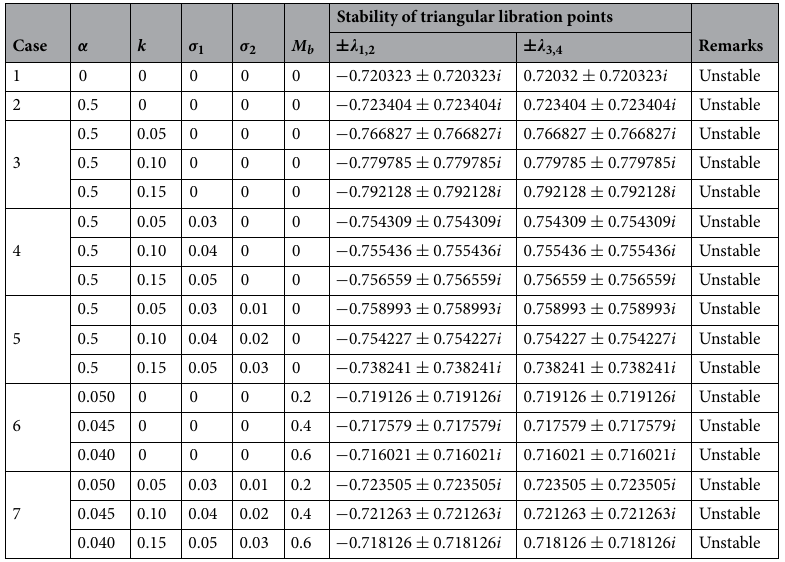
Table 7. Stability of triangular libration points for the Earth–Moon system (µ = 0.01215, A = 0.0000003686, e 0.0549, γ 0.0004527, T 0.01 ) = = − =